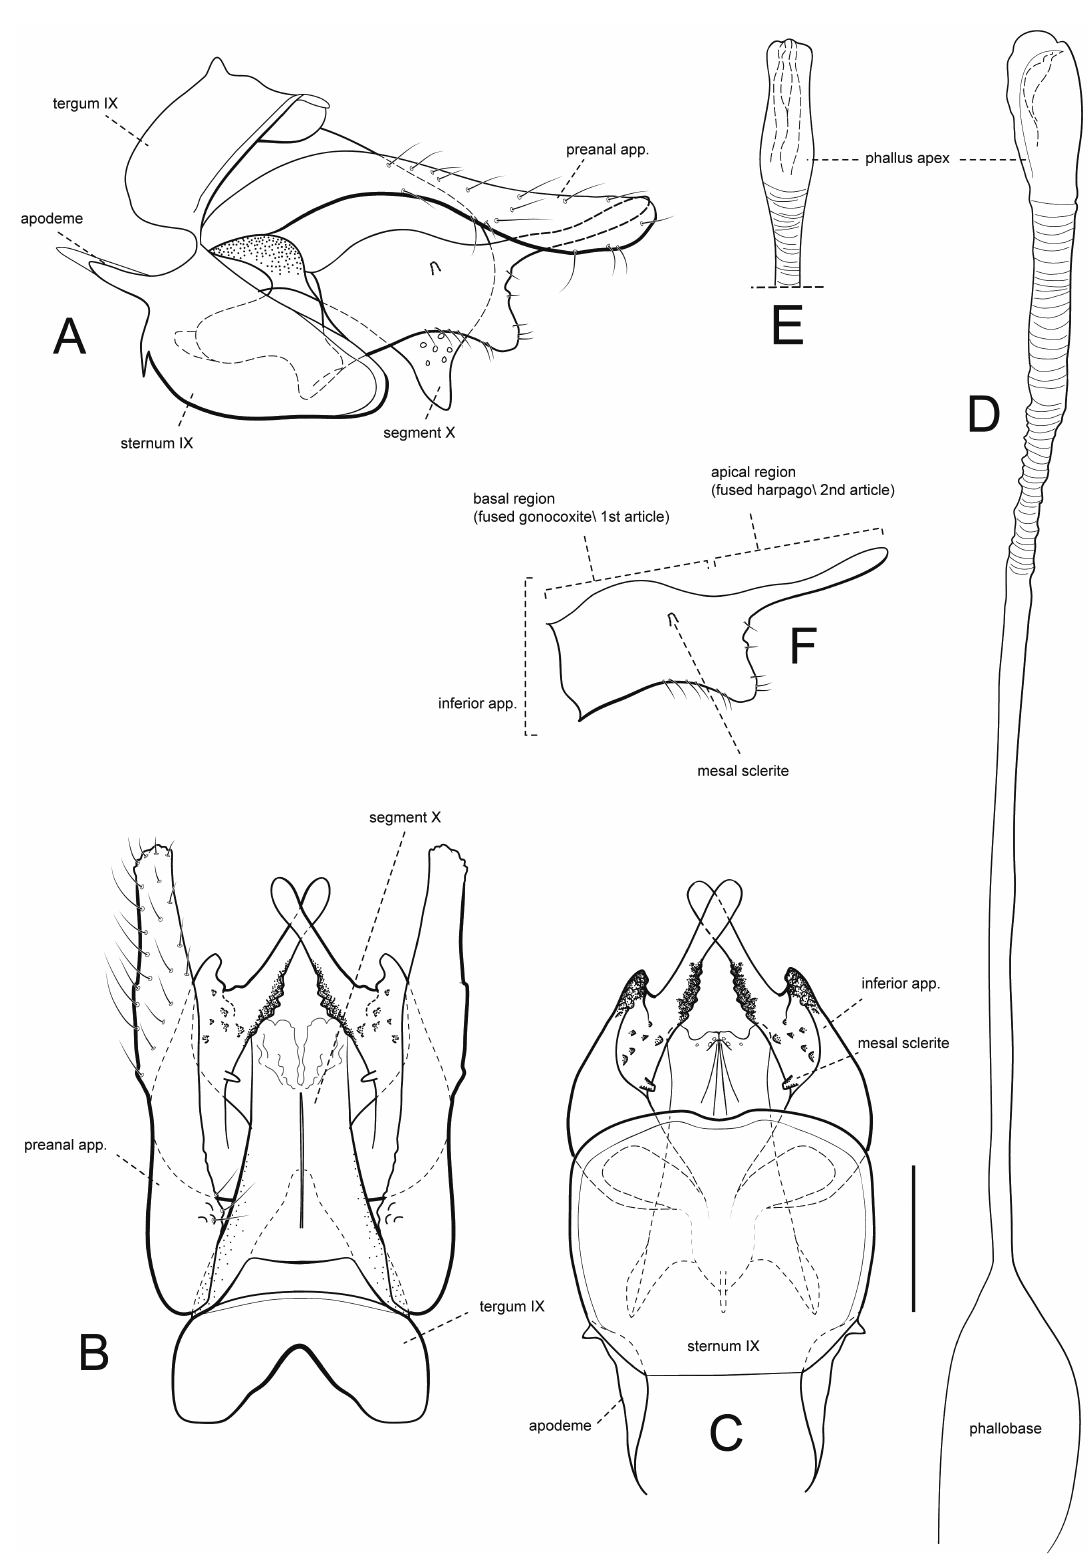
Fig. 3. Xiphocentron ( Antillotrichia ) copacabana sp. nov., holotype, adult, ♂, genitalia. A . Left lateral view. B . Dorsal view. C . Ventral view. D . Phallus in full length, left lateral view. E . Phallus, apex in dorsal view. F . Detail of inferior appendage, left lateral view. Scale bar = 0.1